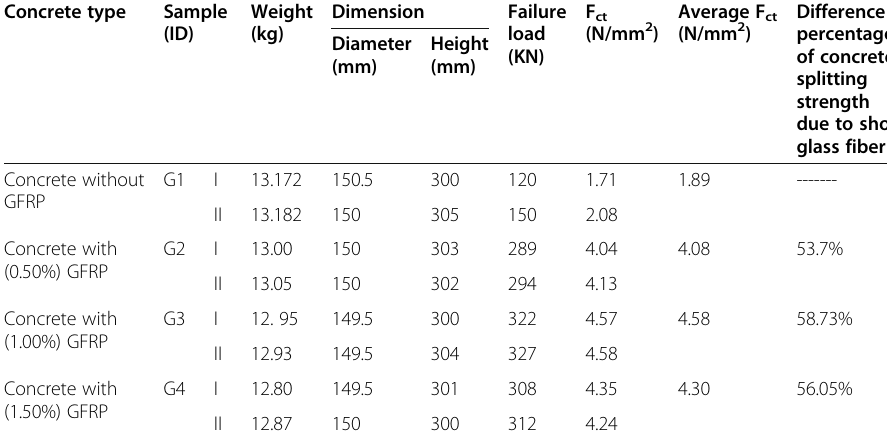
Table 3 Splitting concrete strength Concrete type